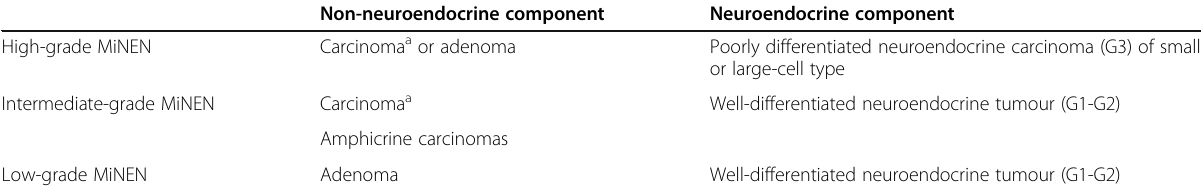
Table 2 Classification of MiNEN according to their grade of